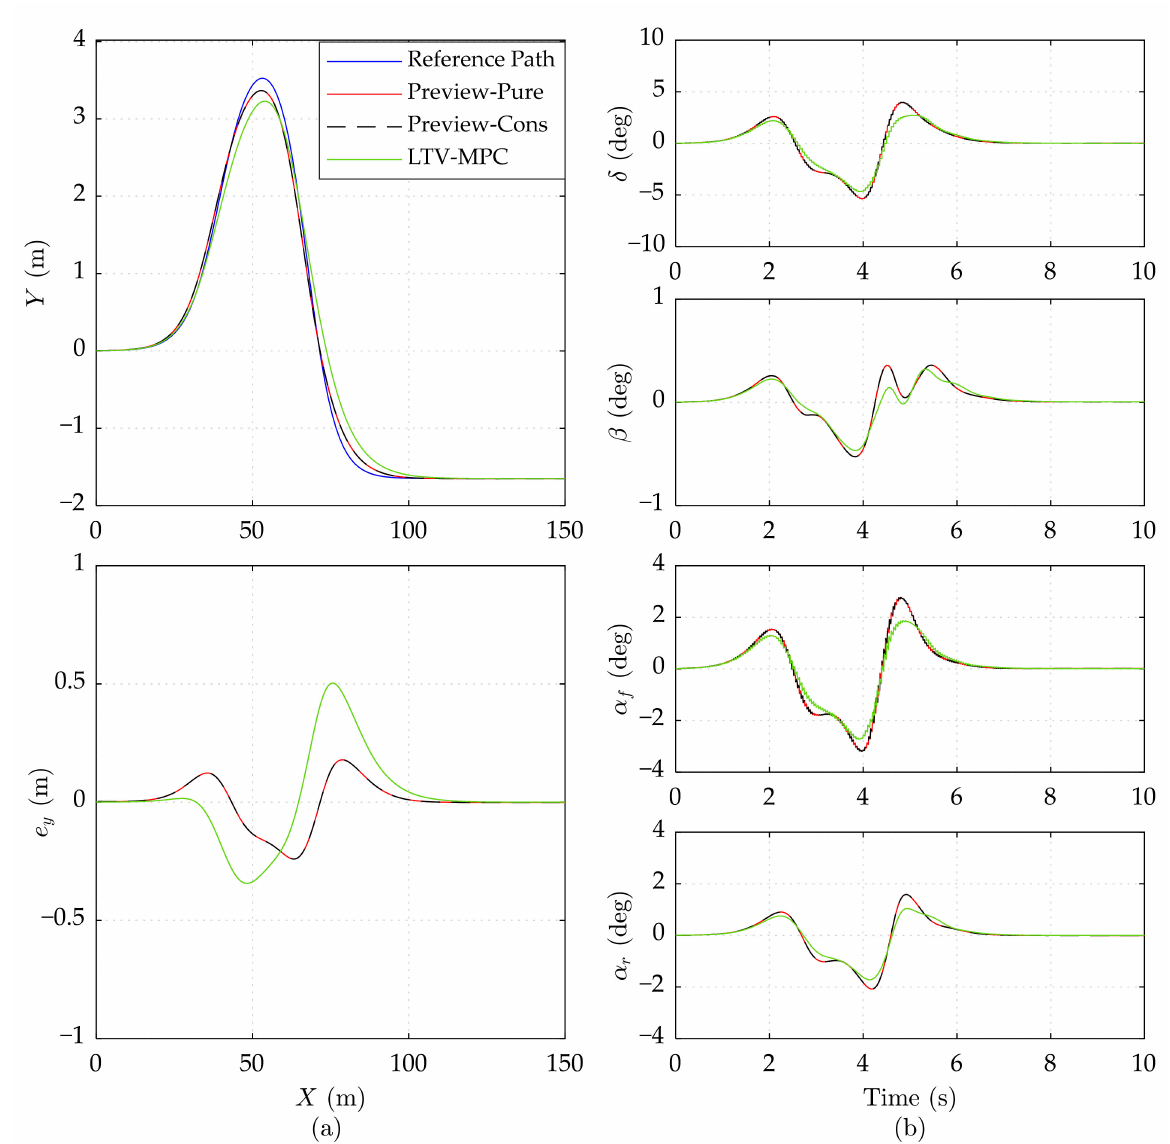
Figure 4. Simulation results of three controllers on the high adhesion road at 15 m/s speed. ( a ) Vehicle driving trajectory, lateral error e y . ( b ) Front wheel steering angle δ , mass center slip angle β , front wheel slip angle α f , and rear wheel slip angle α r